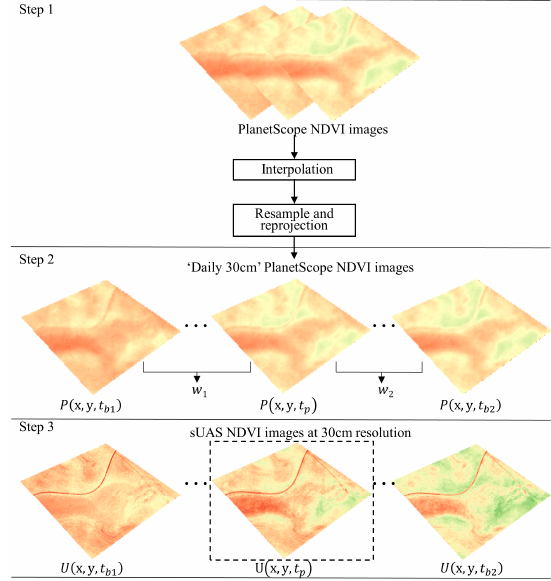
Figure 2. Flowchart for the data fusion method to combine the monthly sUAS imagery and more frequent PlanetScope imagery. (Step 1) PS imageries are first interpolated daily and preprocessed to the same projection and resolution as the sUAS imageries. (Step 2) The preprocessed daily PS imageries are used to calculated weights based on correlations between base imageries (on t b1 and t b2 ) and the imagery on t p . (Step 3). Finally, the predicted NDVI values are computed from the weighted NDVI values from both PS and sUAS (Equation